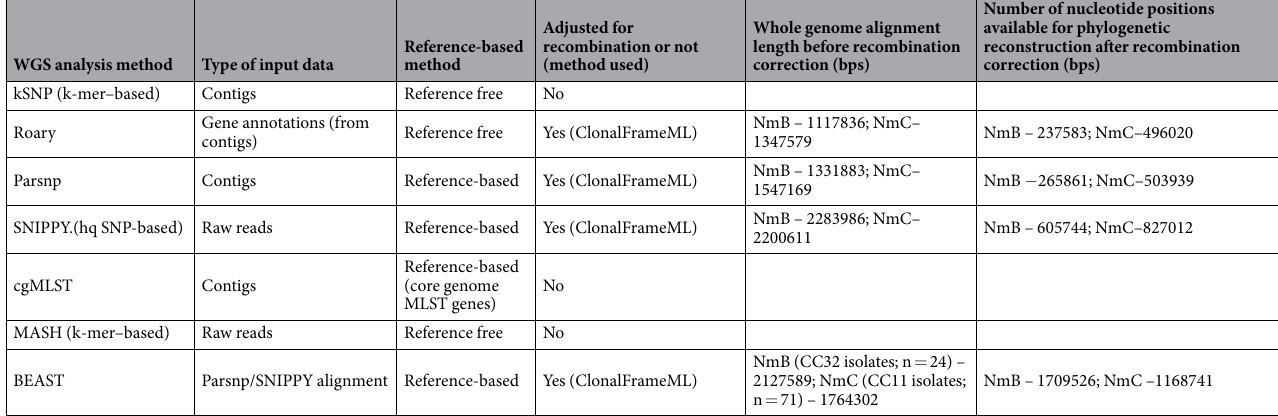
WGS typing methods for phylogenetic classification of Nm outbreak isolates. The 6 WGS anal- ysis methods (Table 2) demonstrated high discriminatory power for classifying NmB and NmC outbreak isolates (Figs 1 and 2) phylogenetically or by genetic distance measures (Supplementary Tables 1 and 2). Isolates from each of the 6 NmB outbreaks (OB1, OB3, OB11, OB12, OB13, and OB15) and 4 NmC outbreaks (OB2, OB4, OB5, and OB14) were grouped into distinct phylogenetic outbreak clades. Isolates from each of the remaining 2 NmB (OB6 and OB10) and 3 NmC outbreaks (OB7, OB8, and OB9) were scattered into more than one phylogenetic clade. Direct qualitative comparison showed that topologies of the phylogenetic trees reconstructed by various WGS analysis methods were similar to each other. Quantitative pairwise tree distance measures using weighted Robinson-Foulds (wRF) showed high similarity between methods that accounted for recombination (SNIPPY, Roary and Parsnp; mean wRF distances were 0.292 and 0.002 for NmB and NmC respectively) and between methods that did not account for recombination (kSNP and cgMLST; mean wRF distances were 0.619 and 0.362 for NmB and NmC respectively). The average pairwise wRF distances between the trees reconstructed with and without accounting for recombination for NmB and NmC were 4.503 and 2.069 respectively (Supplementary Table 3). The intra-outbreak genetic distances ranged from 0 to 186 SNPs/allele differences (Supplementary Table 1). The maximum intra-outbreak SNP differences were less than or equal to the minimum inter-outbreak SNP differences for the recombination-adjusted methods (SNIPPY, Parsnp and Roary). Although the range of esti- mated intra-and inter-outbreak SNP/allele differences for methods without recombination adjusted (kSNP and cgMLST) were higher than the recombination-adjusted methods, they are generally proportional (Supplementary Table 1). For kSNP and cgMLST, we also observed overlap between the maximum intra outbreak SNP/allele differences and the minimum inter outbreak SNP/allele differences for a few outbreaks (Supplementary Table 1). The pairwise genetic distance measures (SNP/allele differences) between outbreak and sporadic isolates were estimated. The mean genetic distances (SNP/allele differences) between outbreak isolates from a single phy- logenetic clade and any sporadic isolates ranged between 209 and 1418 SNPs/alleles, depending on the method (Supplementary Fig. 3). The maximum dissimilarity measures within NmB and NmC outbreaks by MASH were 0.04% and 0.09%, respectively, while the average dissimilarity measure observed between outbreak isolates and any sporadic isolates were 1.83%. Comparison of PFGE and WGS for assessing genetic relatedness of Nm outbreak isolates. Based